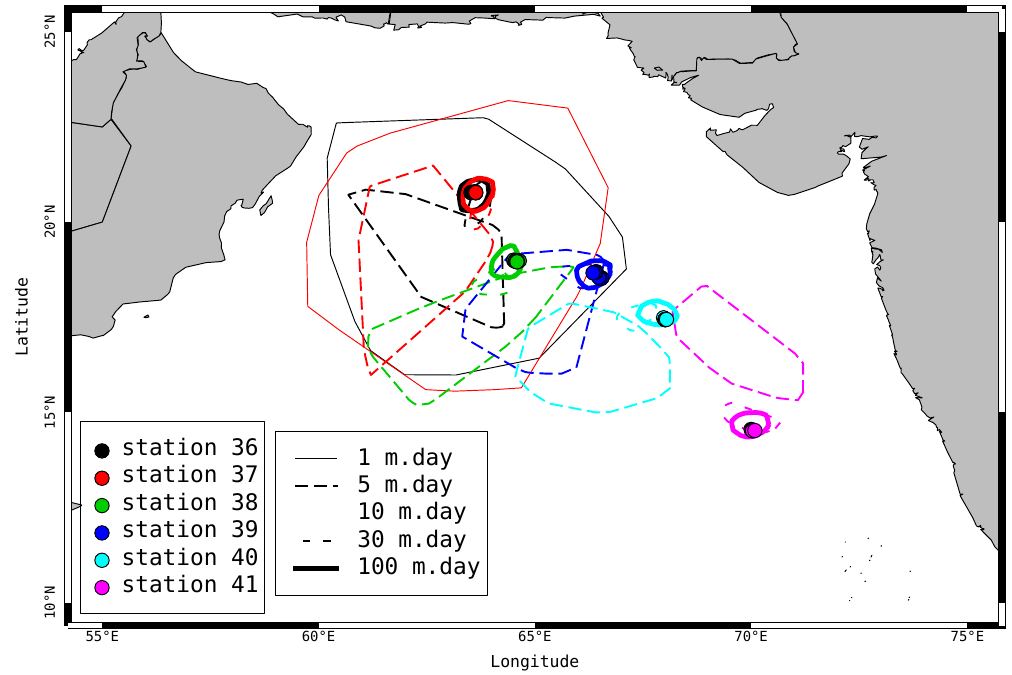
Figure 12. Results from backward Lagrangian simulations. Each envelope contains the 75% of the initial particle number locating possible source of particles observed in each vertical profiles. Five settling velocities were used (see legend). Note that envelopes are drawn only if more than 100 particles have reached the